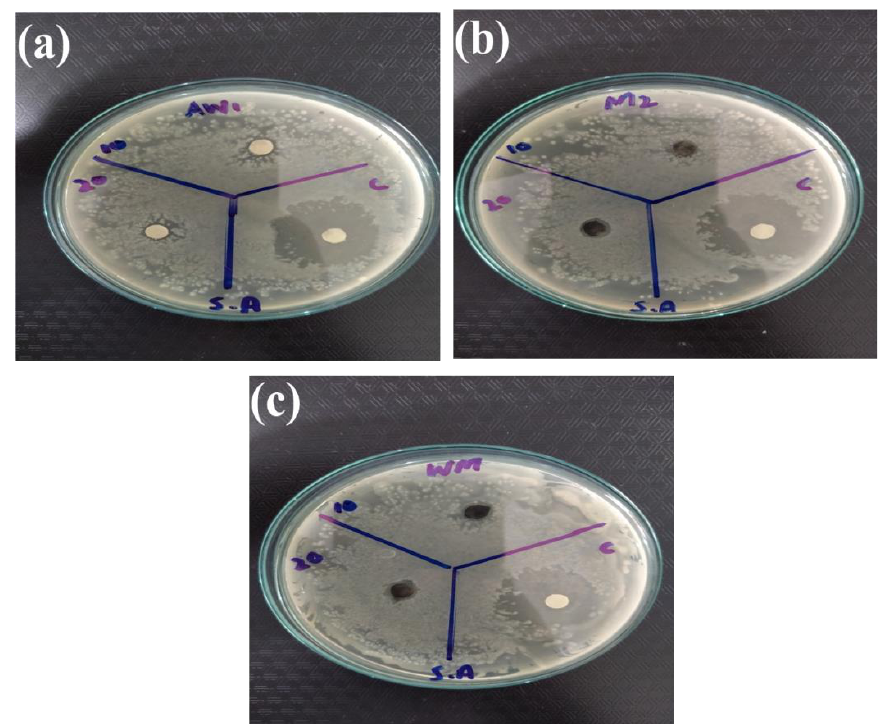
Table 3. Results of antibacterial activity of as-synthesized samples. Sr. No.